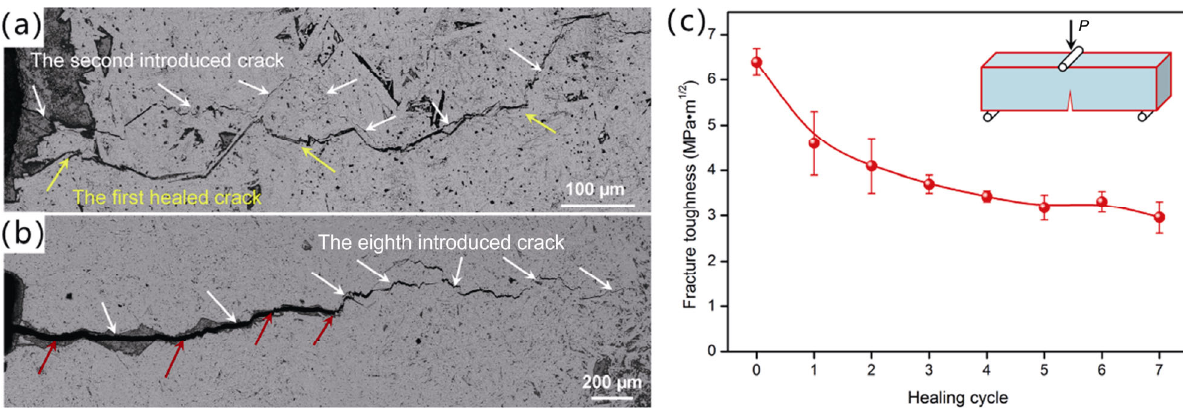
Fig. 5 Back-scattered SEM images of fracture and crack healing of Ti 2 AlC samples. (a) Crack path after one cycle of healing and subsequent fracture. The yellow arrows indicate the crack completely filled, and the white arrows indicate the new introduced crack. Note that the subsequent crack almost deflects around the healed zone of the first crack. (b) Crack path after seven cycles of healing and the subsequent fracture. The red arrows indicate the location of remnant crack parts. (c) Fracture toughness as a function of the number of fracture and healing cycles. The first value for the fracture toughness (i.e., for cycle number, 0) pertains to the virginal material. The error bars indicate the standard deviation. Reproduced with permission from Ref. [83], © Elsevier Ltd.